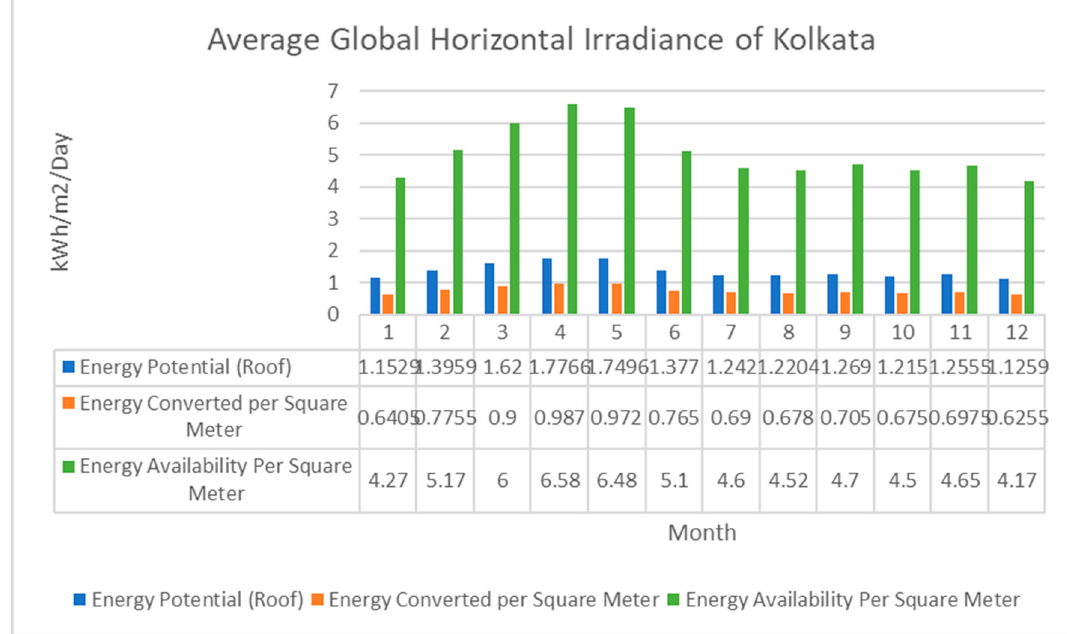
Figure 7. Average global horizontal irradiance of Kolkata.